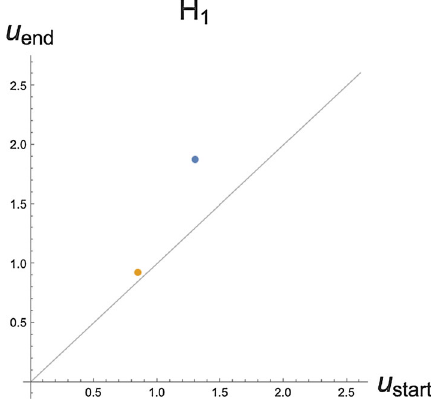
Fig. 13 The persistentdiagram corresponding tothe right barcode dia- gram in Fig. 11. A line segment in a barcode diagram is represented by a dot in a persistent diagram. The longest one is represented by a blue dot, and the second by a yellow one. The colors are also used in the persistent diagrams in Sect.